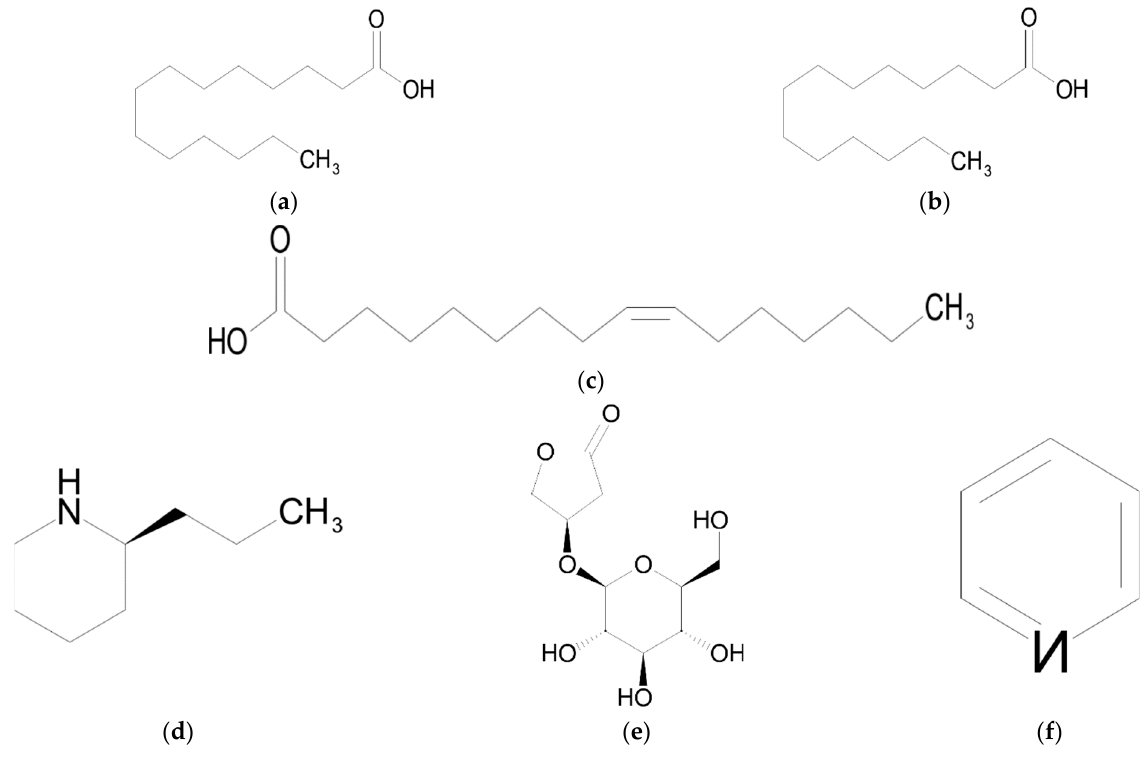
Figure 5. Chemical structures of fatty acids and other compounds from Sarraceniaceae species: ( a ) tetradecanoic acid; ( b ) hexadecanoic acid; ( c ) (Z)-9-hexadecenoic acid; ( d ) coniine; ( e ) goodyeroside; ( f ) pyridine.